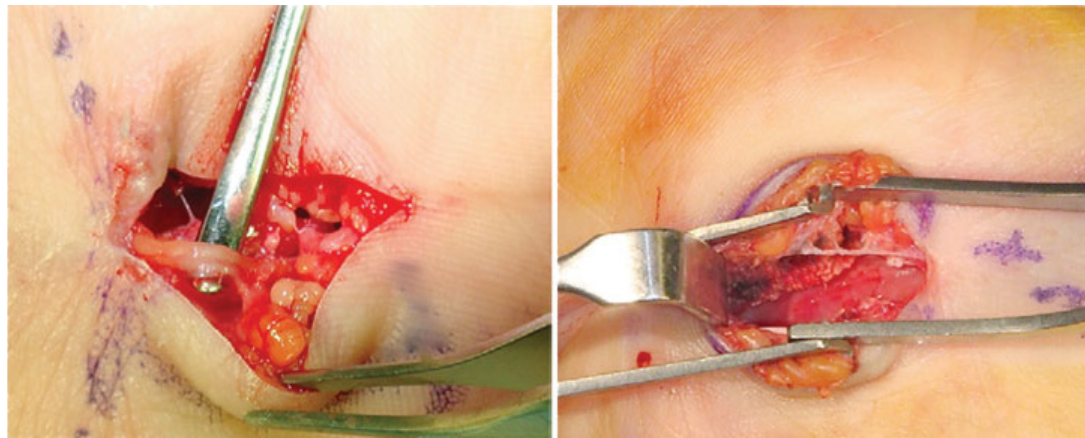
Fig. 1 Mini-open carpal tunnel